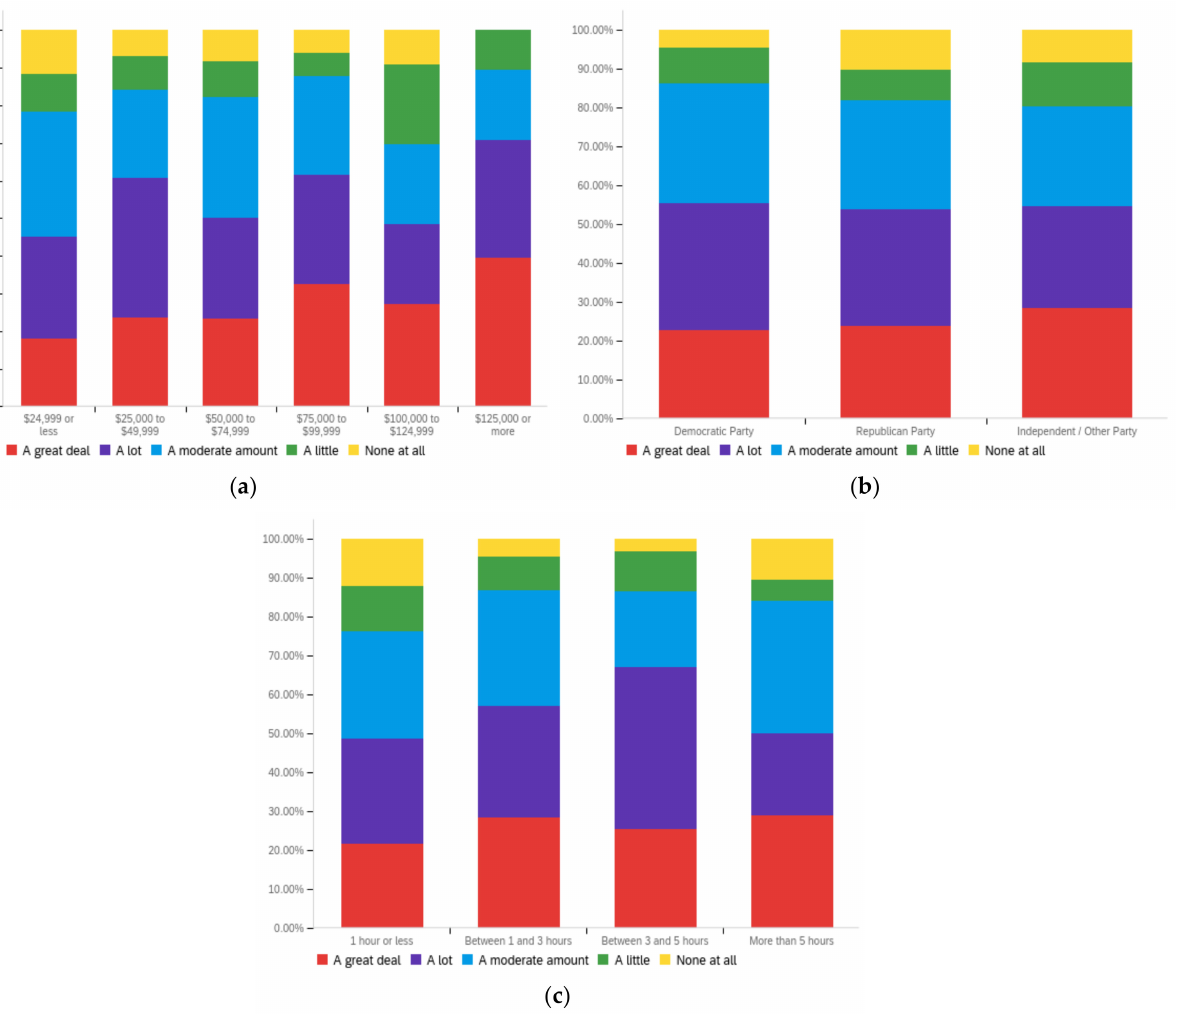
Figure A16. Article author’s political alignment—personal perception impact by: ( a ) income level (top left), ( b ) political affiliation (top right) and ( c ) online usage (bottom).